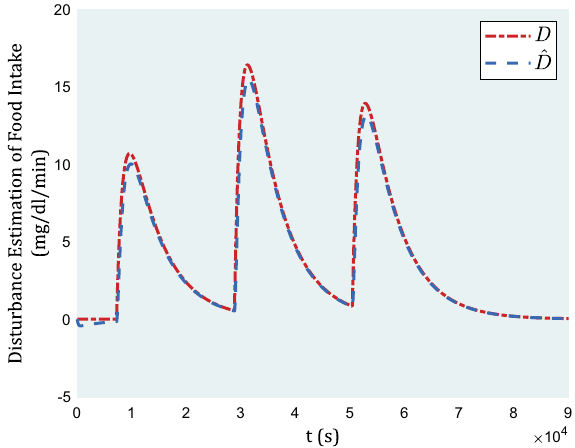
Figure 5. Estimation of blood glucose induced by meals as a disturbance.